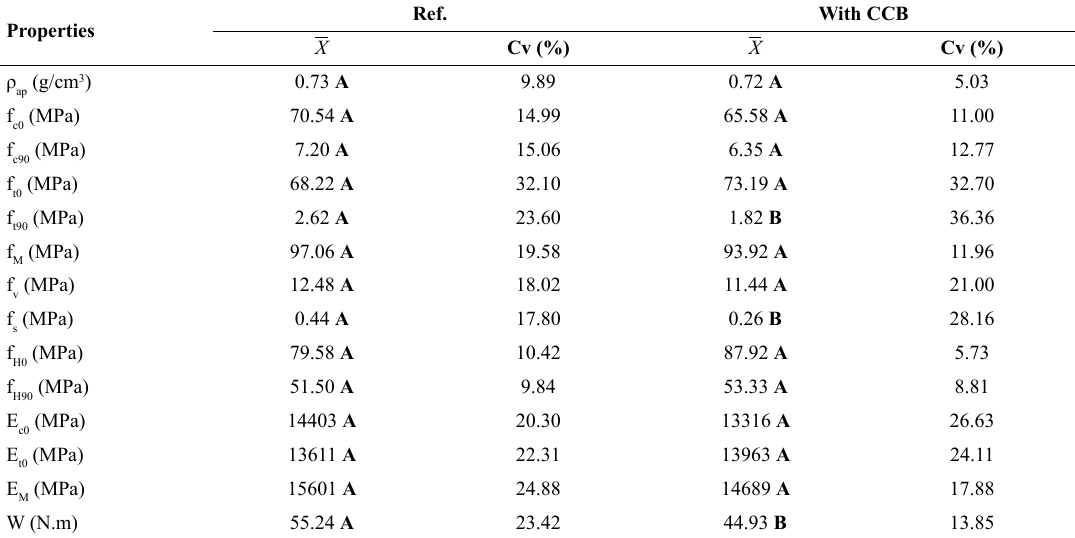
Table 6. Mean experimental values, coefficients of variation (Cv) and Tukey test results for the properties evaluated for Erisma uncinatum Warm (Cambará). Properties